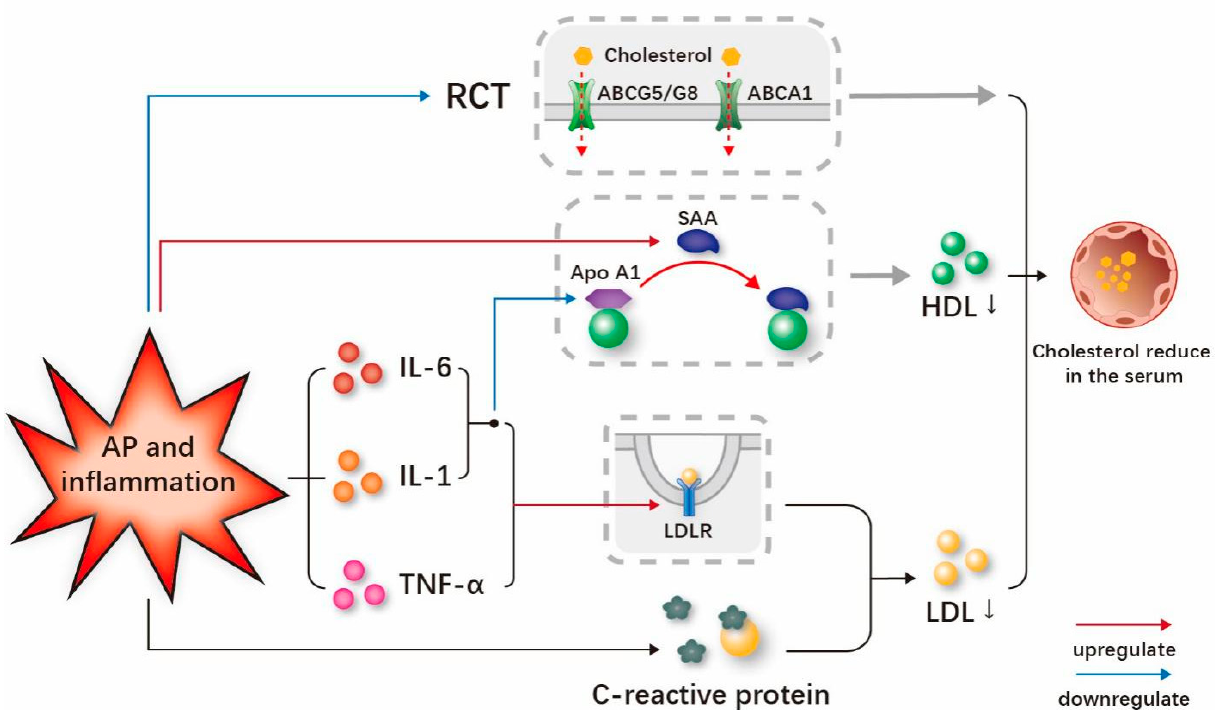
Figure 5. Mechanisms of serum cholesterol reduction caused by persistent inflammation and AP. In the process of persistent inflammation and AP, the release of IL-1, IL-6 and TNF- α increases the expression and activity of LDL-C receptors and leads a decreased LDL-C level. C-reactive protein, a marker of inflammation, also combines with LDL-C to form a complex that can be rapidly degraded to lower LDL-C levels. The excessive release of IL-1 and IL-6 also decreases the serum level of Apo A1. With the decrease in the Apo A1 level, the SAA level increases, and SAA replaces Apo A1 as the main lipid in HDL-C. This change in HDL-C speeds up the clearance of HDL-C from the circulation and leads to a decrease in HDL-C levels. RCT is also damaged in the process of inflammation and AP, and the decreased expression of ABCA1, ABCG5 and ABCG8 mRNA blocks the efflux of cholesterol, which is also one of the mechanisms of the decrease in the serum cholesterol level. Abbreviations : IL-6, interleukin-6; IL-1, interleukin-1; TNF- α , tumor necrosis factor- α ; HDL-C, high-density lipoprotein cholesterol; LDL, low-density lipoprotein cholesterol; SAA, serum